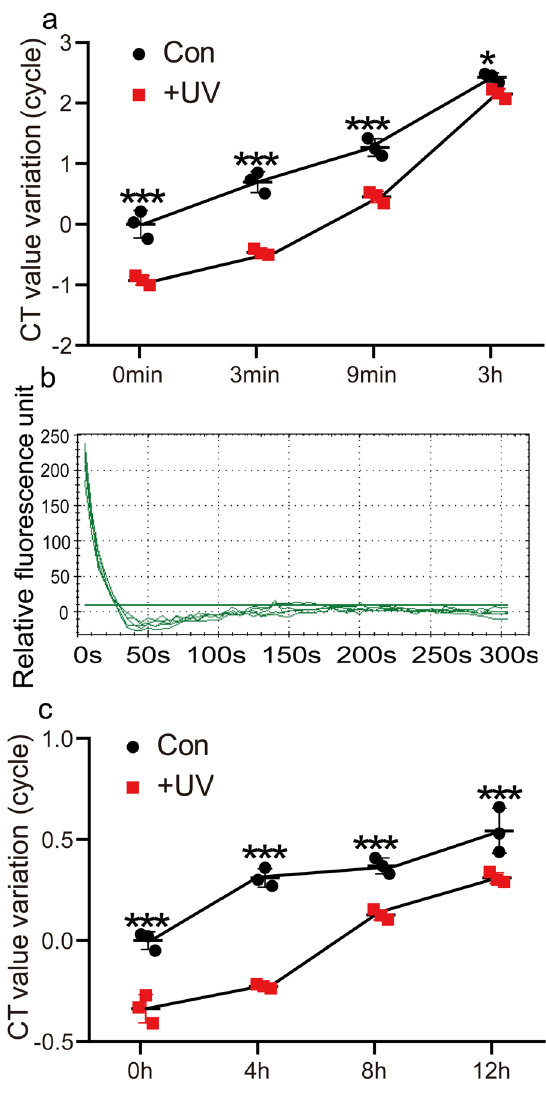
Fig. 4 The effects of heat treatment and hybridization on denaturing cross-linked chromatin and decross-linking. a Analysis of the decross- linking of chromatin after exposure to heat treatment. Two methods for crosslinking chromatin were used, including 3% (w/v) formaldehyde and 20 mg L − 1 NiSO 4 (Con), and 3% (w/v) formaldehyde and 20 mg L − 1 NiSO 4 combined with ultraviolet radiation treatment (UV). The cross-linked chromatin was incubated in LS buffer [with 10% (v/v) formamide, 0.5% (w/v) SDS] at 90 °C for different times, and the decross-linked DNA